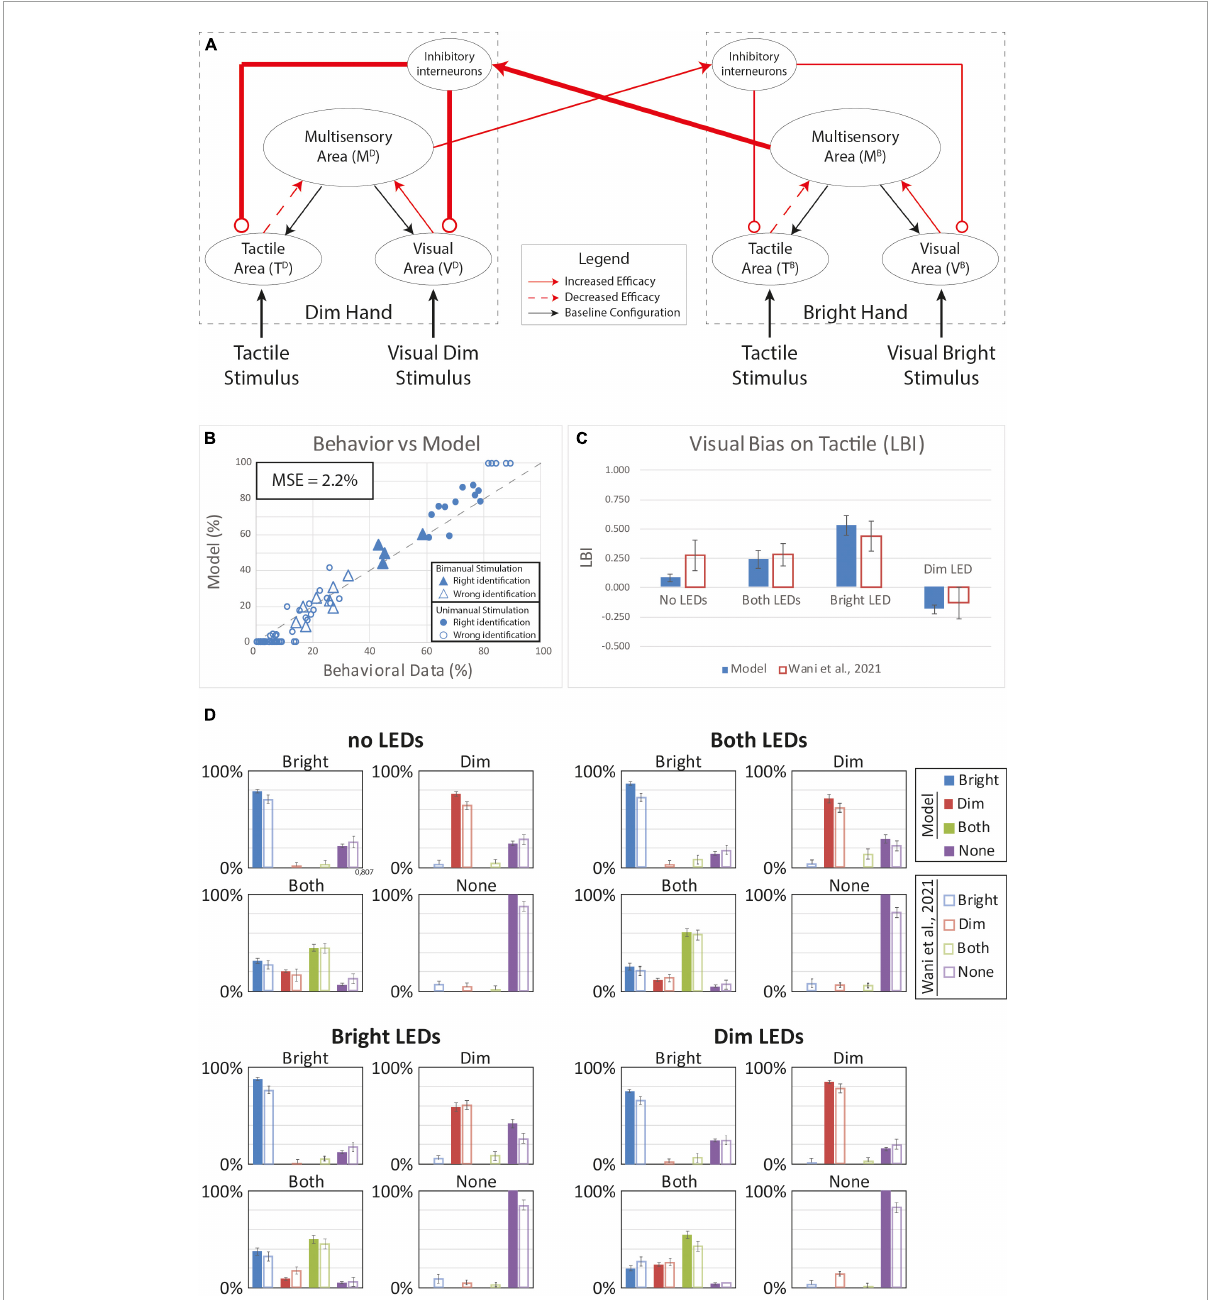
FIGURE7 Simulated tactile perception in case of sensory reorganization paired with a stronger inter-hemisphere competition. (A) Model’s structure with the altered pattern of connectivity. Red lines highlighted the modified synapses. Thick synapses represent stronger reinforcement; thin lines correspond to a weaker reinforcement. Moreover, for each hand representation, red solid arrows identified synapses with increased efficacy, red dashed arrows the synapses with lower efficacy. (B) Behavioral data from Wani et al. (2021) are compared with Model’s results, for the 16 different stimuli configurations. The dashed line represents the “perfect” match between simulations and behavioral results. In the diagram the triangles represent the tactile responses in case of bimanual tactile stimulations, irrespective of the visual stimuli. Full triangles refer to the correct identification of bimanual stimulations; empty triangles report the percentages of different sensory perceptions. Circles report the responses to unimanual tactile stimulations, regardless of the positions of the visual stimuli. Full circles represent the correct responses, empty circles report the other responses. (C) Lateralization Bias Index (LBI) computed for the 4 different visual conditions. (D) In each box we reported the percent tactile responses ( y -axis), distributed across the four possible choices (Bright, Dim, Both, None, on the x -axis), mediated over the 20 simulated subjects, to a specific tactile input (T) configuration, specified in each box title: T on the bright hand, “Bright,” on the dim hand, “Dim,” on both hands simultaneously, “Both,” and no stimulus, “None”; and for each visual input stimulation: no LEDs, both LEDs, Bright LED, Dim LED. Errorbars indicate s.e.m. The responses obtained by the model, are compared to the empirical results of Wani et al. (2021)